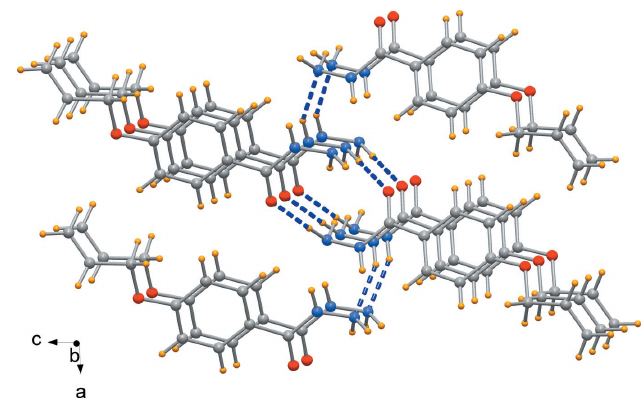
Figure 1 The molecular structure of the title compound showing 50% displace- ment ellipsoids.